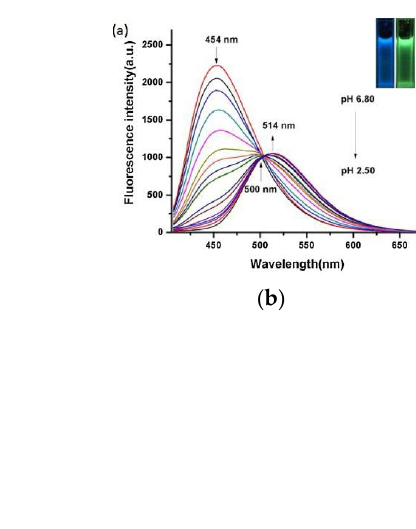
Figure 13. ( a ) The proposed mechanism of RBN for sensing H + ; ( b ) Fluorescence spectra of RBN at different pH values; ( c ) CLSM images of HepG-2 cells and HL-7702 cells incubated with RBN. Re- produced with permission from [74]. Copyright 2017 Elsevier B.V. on behalf of Chinese Chemical